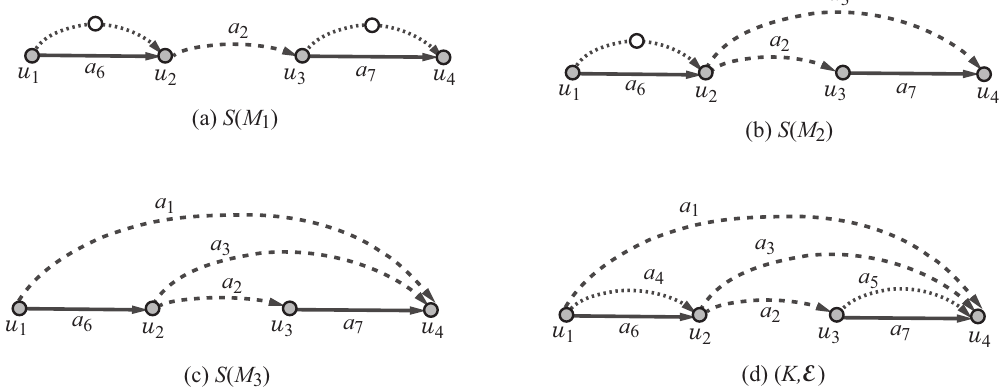
Figure 2. An illustration of the least simple graphs of the rank-2 polymer topologies M 1 , M 2 , M 3 ∈ PT ( 2,4 ) in Figure 1 and a scheme graph ( K , E ) : ( a ) S ( M ) ; ( b ) S ( M ) ; ( c ) S ( M ) ; ( d ) a scheme graph 2 3 1 ( K = ( { u } , E ) , E = ( E )) where each edge u i u j is directed from one end-vertex 1 , u 2 , u 3 , u 4 1 , E 2 , E 3 u i to the other end-vertex u j with i < j , and E 1 = { a 1 = ( u 1 , u 4 ) , a 2 = ( u 2 , u 3 ) , a 3 = ( u 2 , u 4 ) } , E 2 = { a 4 = ( u 1 , u 2 ) , a 5 = ( u 3 , u 4 ) } and E 3 = { a 6 = ( u 1 , u 2 ) , a 7 = ( u 3 , u 4 ) } , and the edges in E 1 (resp., E 2 and E 3 ) are depicted with dashed (resp., dotted and solid)